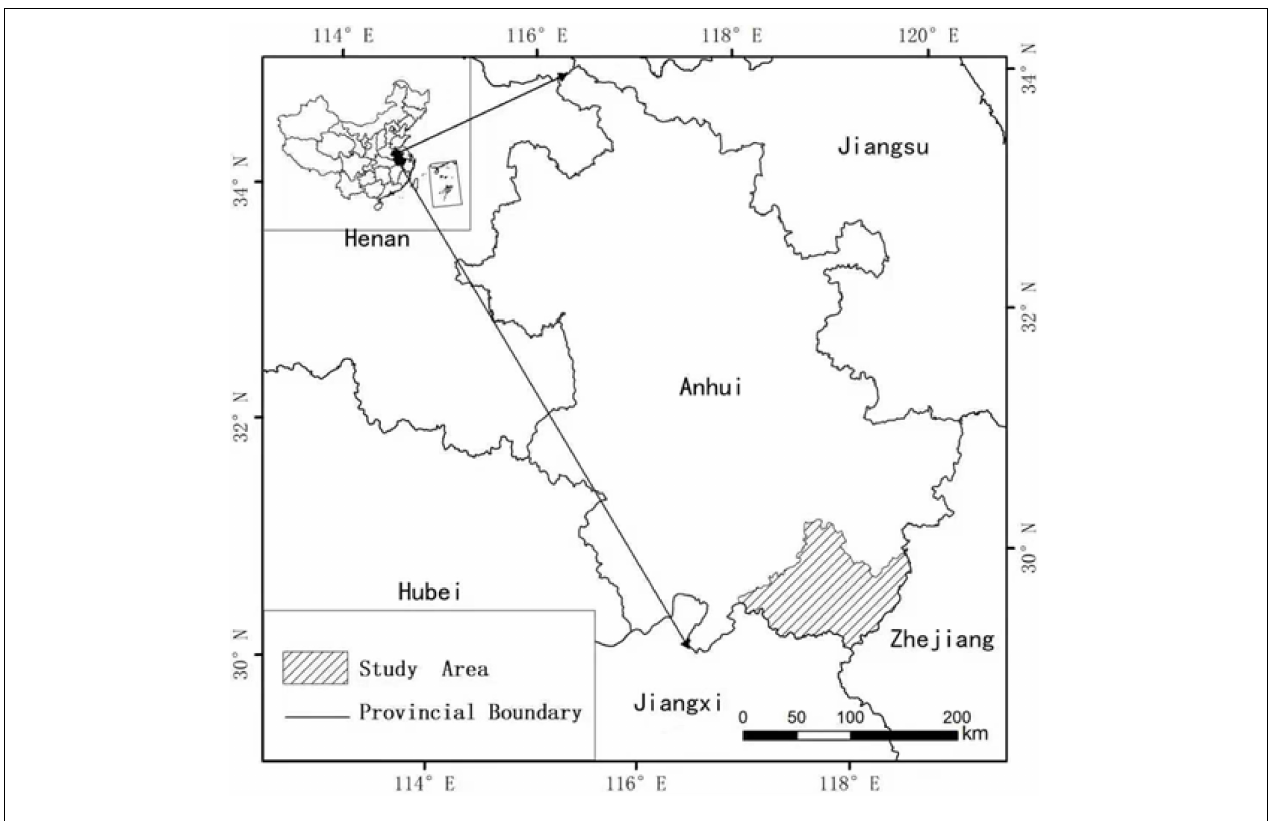
FIGURE 1 | The location of the study area in China. TABLE 1 | Summary of the mean ( ± SE) of the variables investigated in the even-aged pure S. tzumu